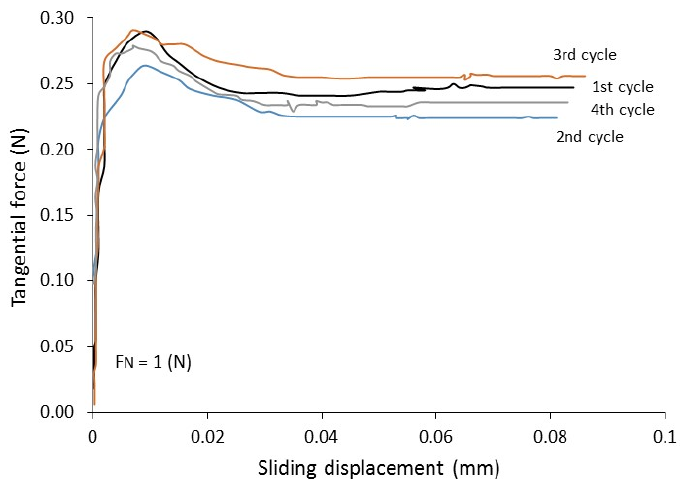
Figure 13. Tangential force–displacement plots at the contacts of LBS grains indicating the effect of the shearing cycle at a normal force of 1 N.